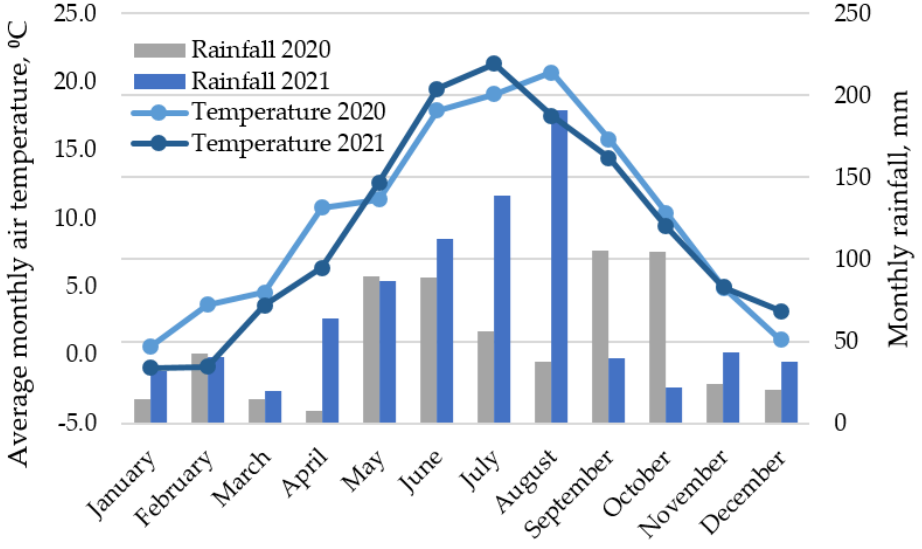
Figure 1. Weather conditions during the experiment .